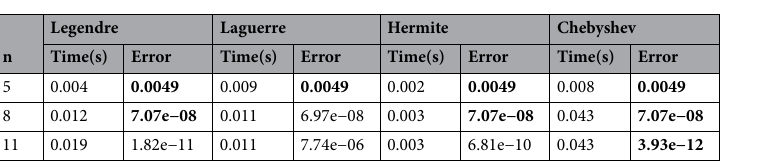
Table 2. Comparision of maximum relative error for Example 6.1 with different numbers of neurons. Significant values are in bold.